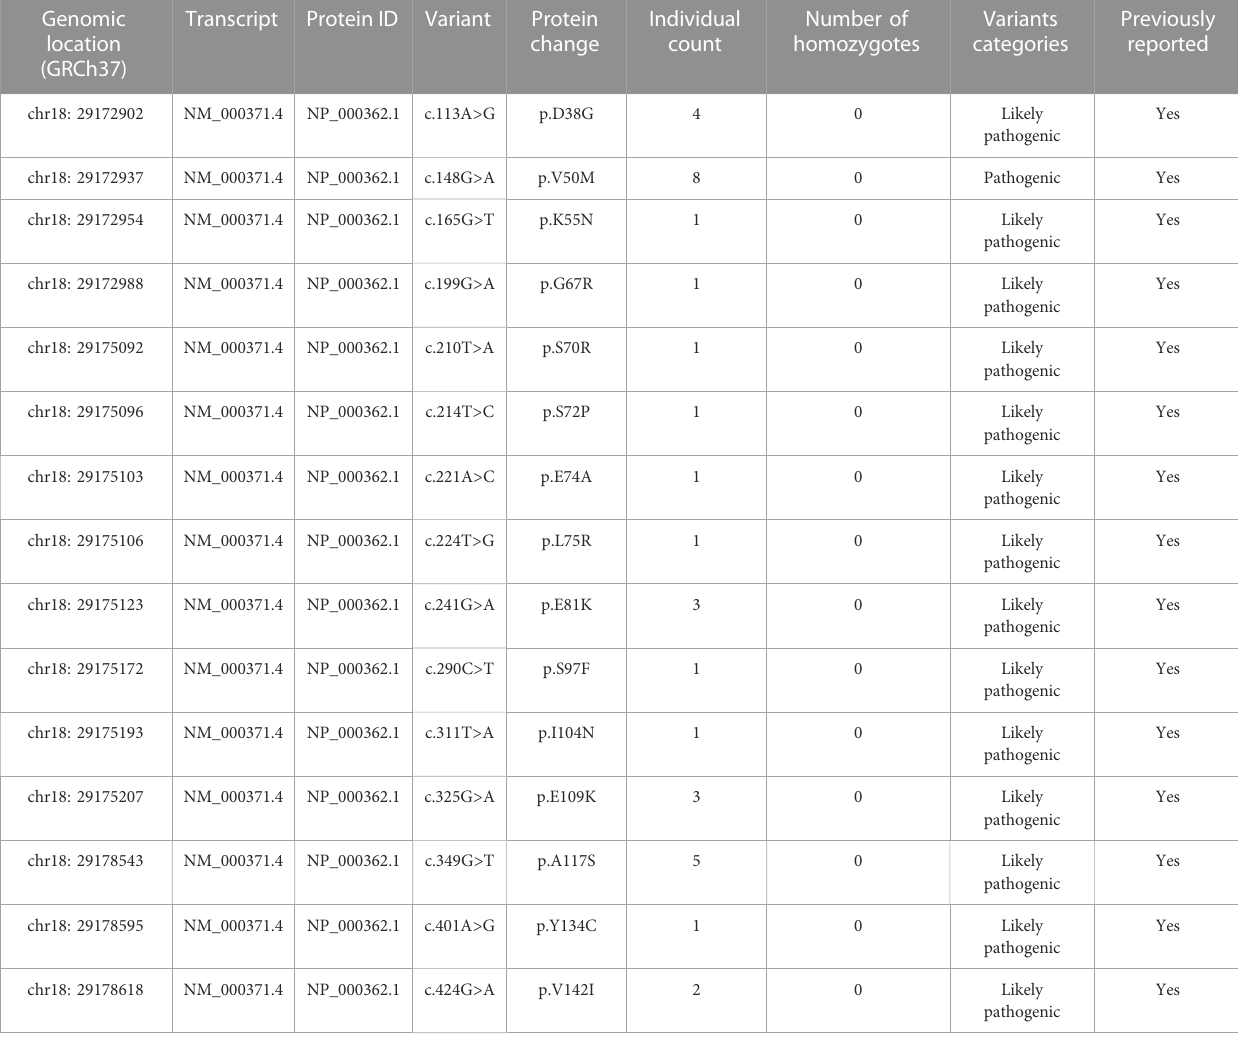
TABLE 2 Variants in the TTR gene classi fi ed as pathogenic variants from the Amcarelab